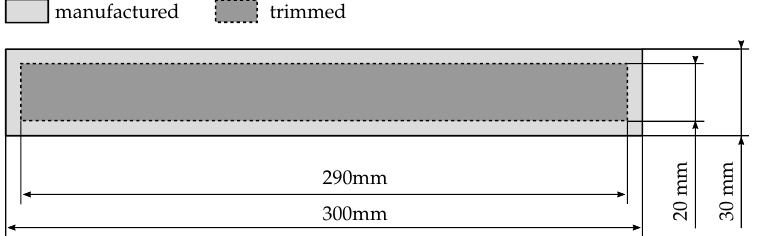
Figure 4. Dimensions of the manufactured and trimmed specimens in their plane